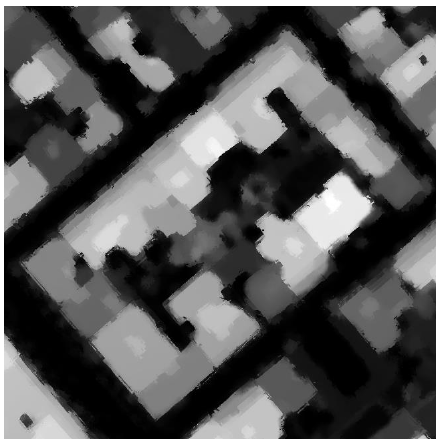
Fig.6 AOI automatic